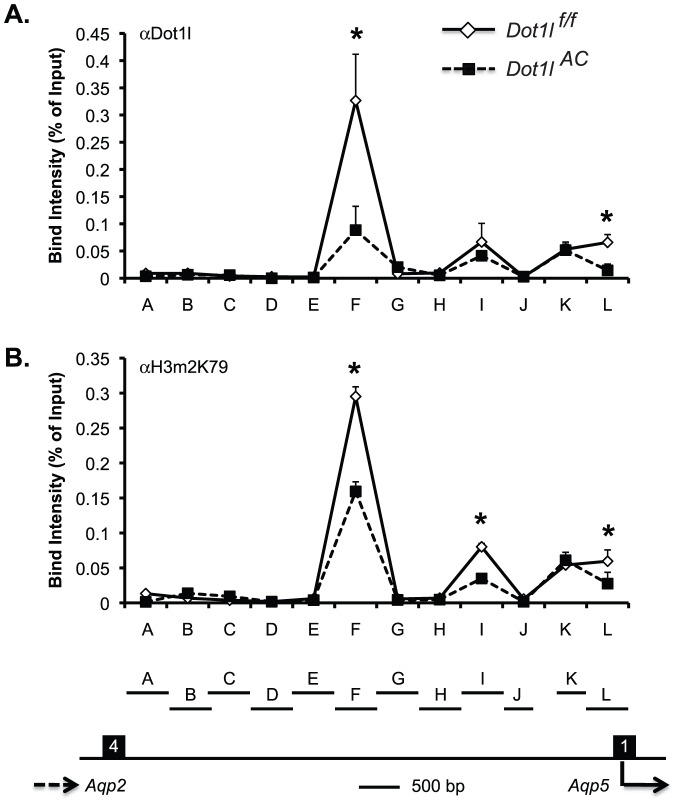
ChIP demonstrates impaired binding of Dot1l and H3m2K79 at specific subregions of Aqp5 5′ regulatory region.Chromatin from Dot1lf/f and Dot1lAC mice on the normal Na+ pellet diet (n = 6 mice/group) was immunoprecipitated by the rabbit antibodies specific for Dot1l (A) and H3m2K79 (B), followed by real-time qPCR with primers amplifying subregions A-L covering almost the whole region between the end of Aqp2 exon 4 and the translation start site ATG of Aqp5 as shown at the bottom. There is a 525-bp gap between J and K, which cannot be reliably amplified and was excluded from further analysis. Relative ChIP efficiency was defined as the immunoprecipitated amount of materials present as compared to that of the initial input sample. *: P<0.05 vs. Dot1lf/f within the same subregion.